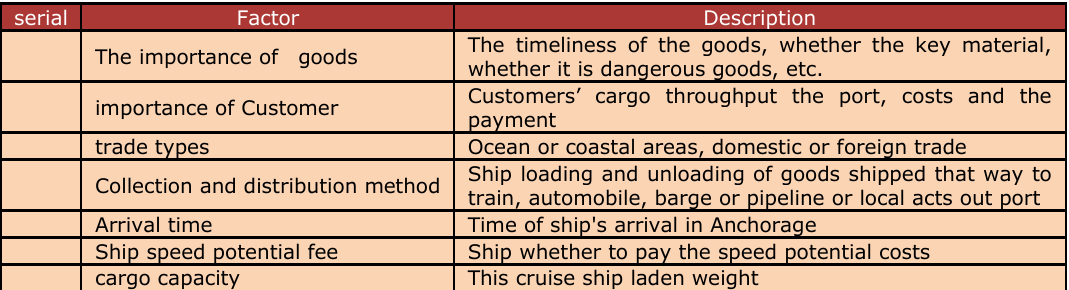
Table 2. Factors of priority about ship using resources